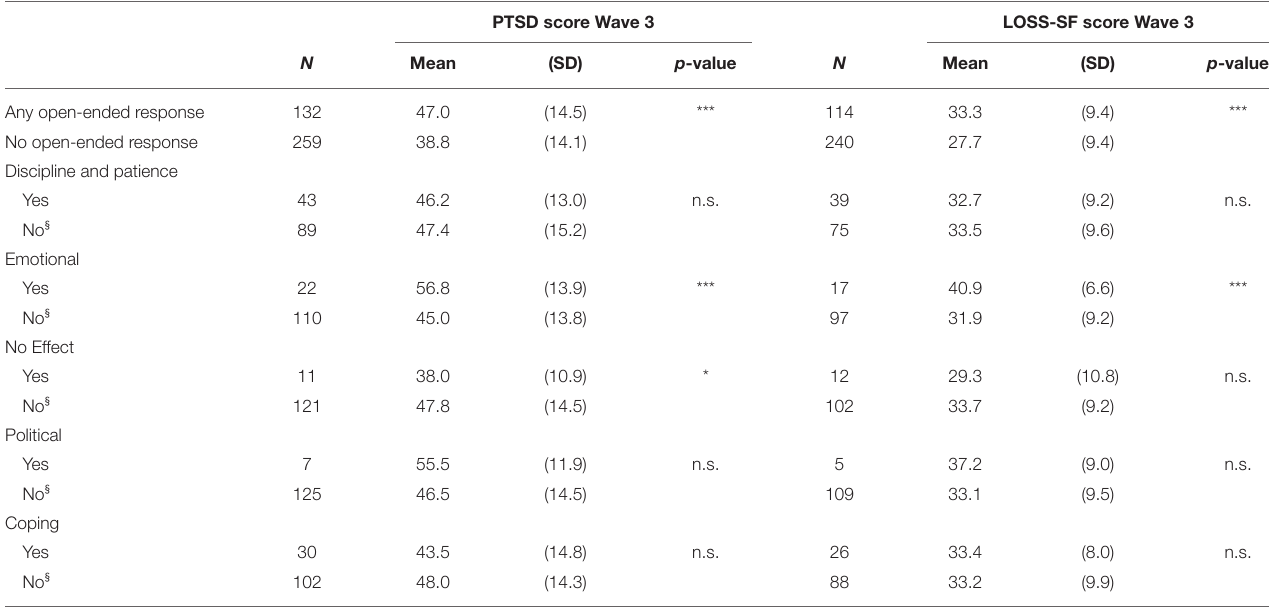
TABLE 3 | Mean scores (SD) of PTSD and LOSS-SF at Wave 3 for veterans who responded to the open-ended question “Please explain how your military experiences have helped or hindered you in dealing with this situation